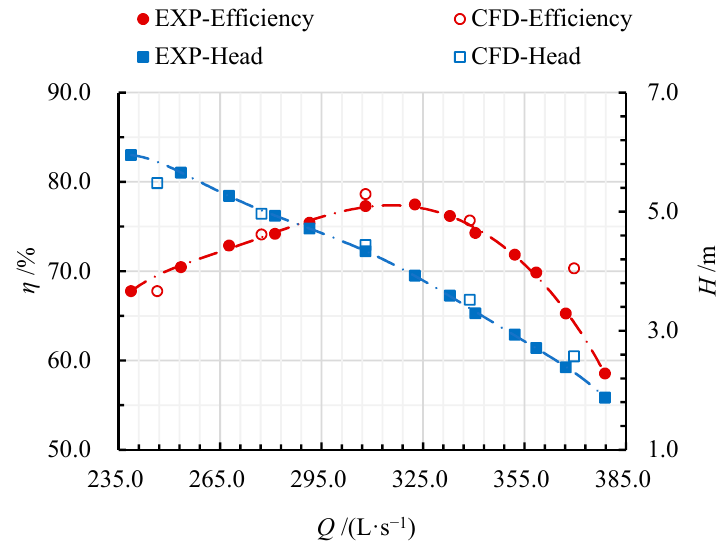
Figure 6. Comparison of pump performance between simulated data and test results ( R t = 0 mm).